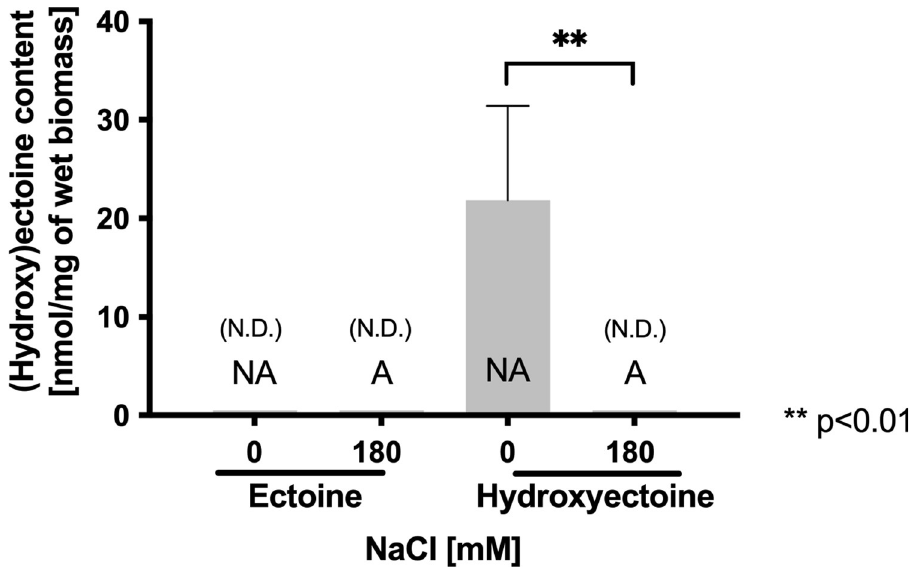
Fig 3. Effect of NaCl adaptation on the content of compatible solutes in L . ferriphilum DSM 14647. Ectoine and hydroxyectoine content was measured in adapted cells exposed to 180 mM NaCl (A) and non-adapted (NA) cells exposed to 0 or 180 mM NaCl. The data represent the average of 3 independent experiments. Error bars represent standard deviation. Statistical analysis was carried out by ANOVA and a T Test. N.D.: not detected.